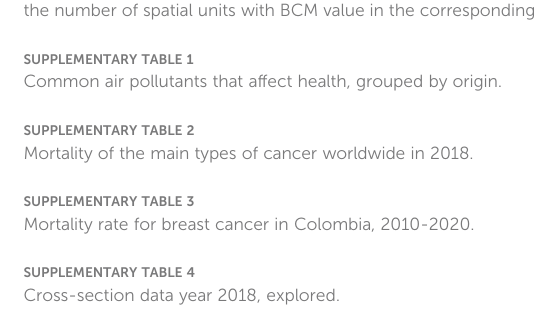
SUPPLEMENTARY FIGURE 1 Evolution BCM in Colombia, 2010-2020 SUPPLEMENTARY FIGURE 2 Spatial dispersion BCM in Colombia – 2018. The spatial units were divided intosixuniformintervalsintermsofBCMRvalues.Betweenparentheses is the number of spatial units with BCM value in the corresponding interval SUPPLEMENTARY TABLE 1 Common air pollutants that affect health, grouped by origin. SUPPLEMENTARY TABLE 2 Mortality of the main types of cancer worldwide in 2018. SUPPLEMENTARY TABLE 3 Mortality rate for breast cancer in Colombia, 2010-2020. SUPPLEMENTARY TABLE 4 Cross-section data year 2018,